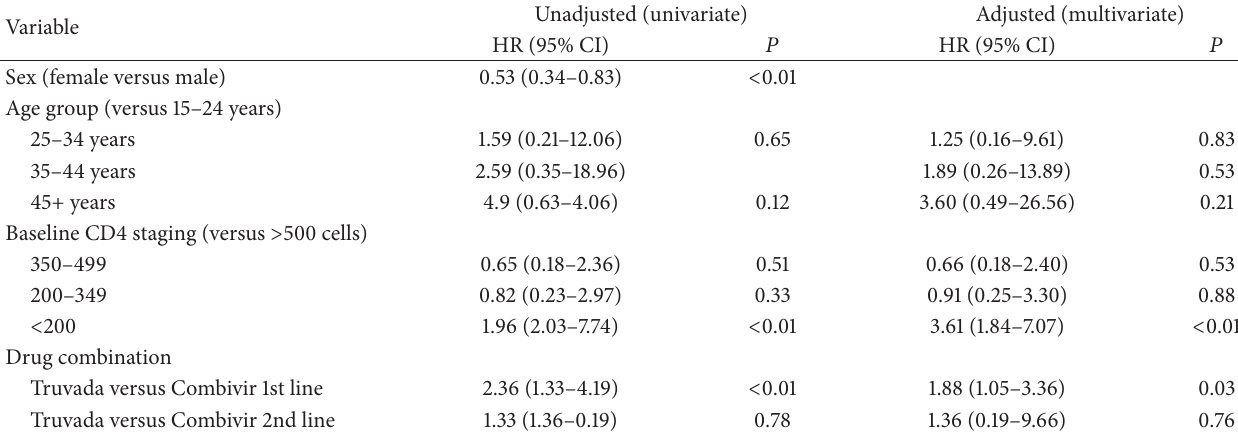
Table 3: Hazard ratios of mortality according to predictors for PLWHA in Nigerian Christian Hospital.